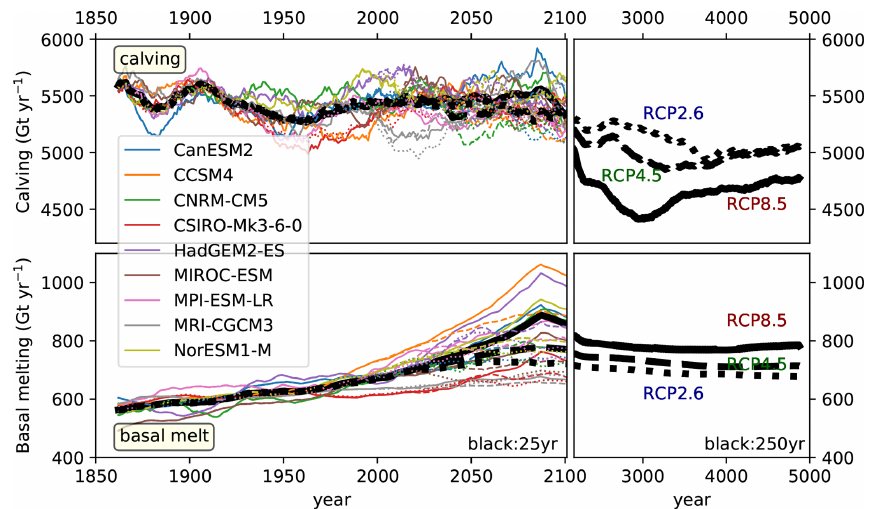
Figure E14. Long-term temporal evolution of the ensemble mean basal melting and calving ice loss rates from 1850 to 2100 and beyond until the year 5000. The upper panels show the calving rates, and the lower panels depict the basal melting rates. In the left panels, individual model simulations (colored lines according to the legend) are grouped together, whereas the thick black lines are the overall means as shown in the corresponding figures (Figs. E12, E13). For the ensemble means of the period from 1850 to 2100, a smoothing with a 25-year moving window is applied (left panels), whereas the smoothing window length is 250 years for the right panels covering the period from 2100 to 5000. The applied running means shift the apparent maximum backward in time so that it occurs visually before the year 2100. Solid, dashed, and dotted lines represent the RCP8.5, RCP4.5, and RCP2.6 scenarios,